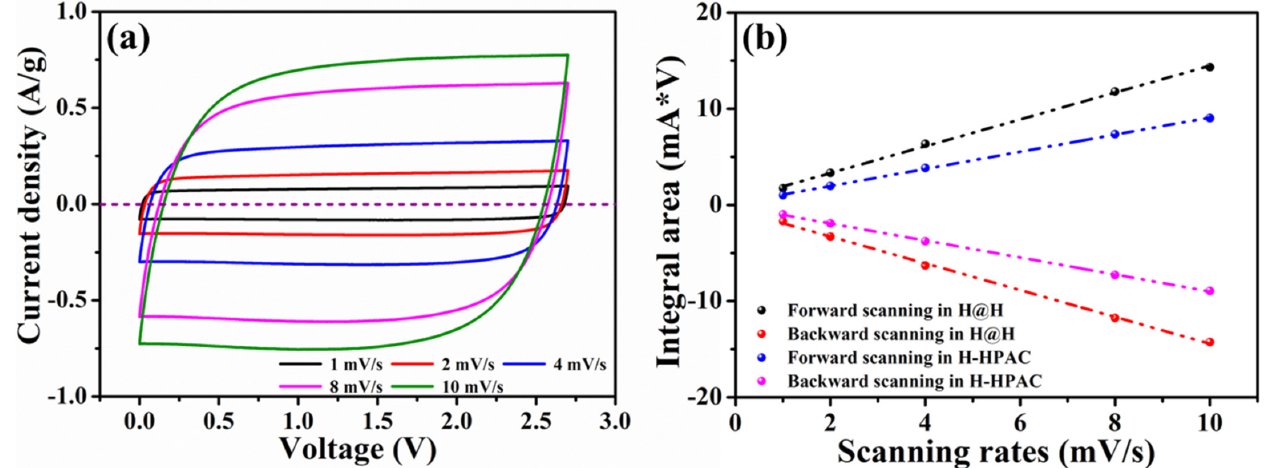
Figure 6. ( a ) Cyclic voltammograms collected in the voltage range between 0 and 2.7 V at scanning rates from 1 to 10 mV/s and ( b ) dependence of the integral area on scanning rate, with the values acquired from ( a ) and Ref. [9] for H@H and H-HPAC,